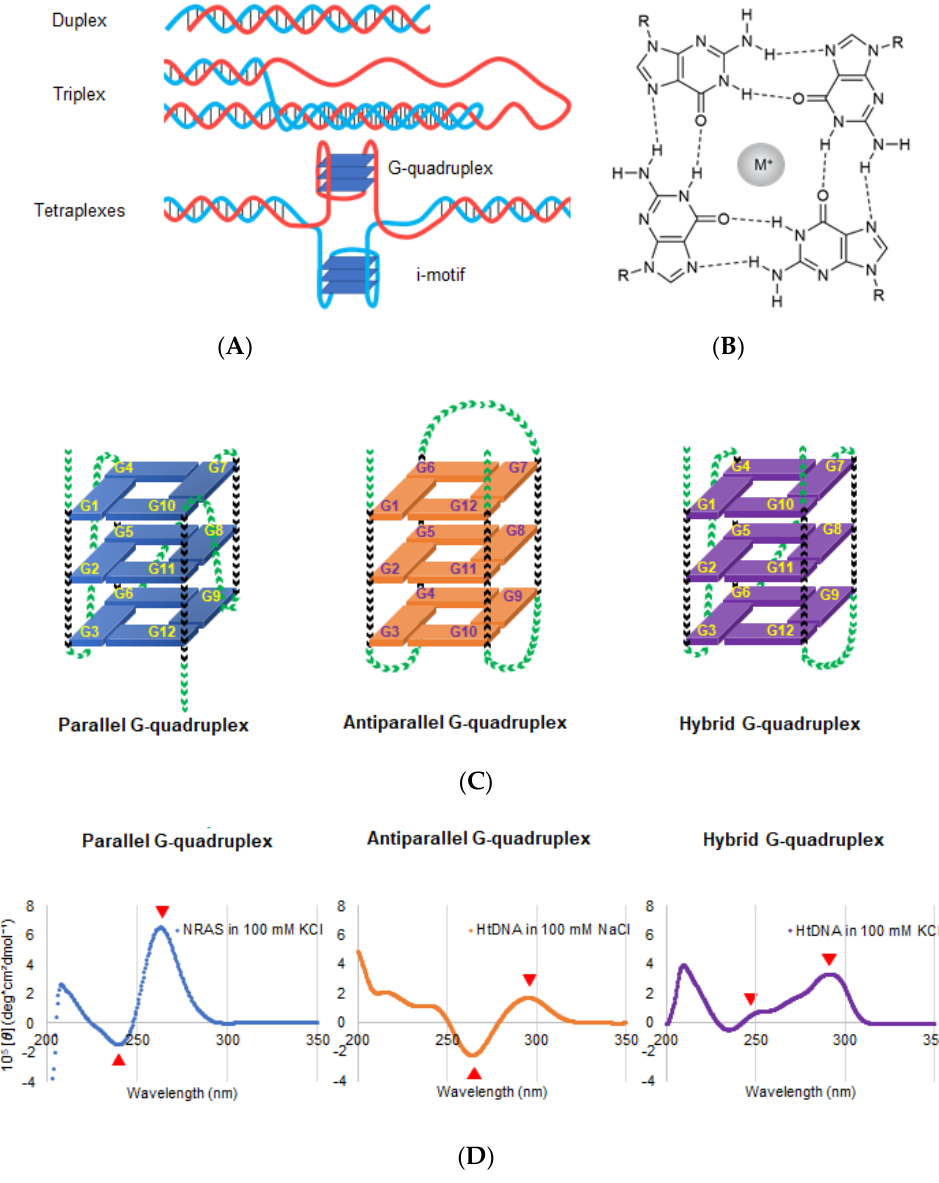
Figure 2. ( A ) Schematic DNA structures; duplex (upper), triplex (middle), and tetraplexes (lower). Tetraplexes including G-quadruplex and I-motif. ( B ) Chemical structure of G-quartets along with the cation coordinates of O6 sites corresponding to four guanines. The sphere with M + in the center of G-quartet represents a central cation. ( C ) Schematic structure depicting the G-quadruplex (G4) folding conformation: parallel (left), antiparallel (middle), and hybrid (right). Green and black arrowheads indicate the loop and guanine region, respectively. ( D ) Typical CD spectra of the parallel, antiparallel, and hybrid conformations. Left: CD spectrum of NRAS DNA, d(GGGAGGGGCGGGTCTGGG), forming parallel G4 in a buffer containing 100 mM K + . Middle: CD spectrum of telomeric DNA, dA(GGGTTA) 3 GGG, forming antiparallel G4 in a buffer containing 100 mM Na + . Right: CD spectrum of telomeric DNA of, dA(GGGTTA) 3 GGG, forming hybrid G4 in a buffer containing 100 mM Na + (right). Red arrows indicate the representative peaks of each G4 conformation.